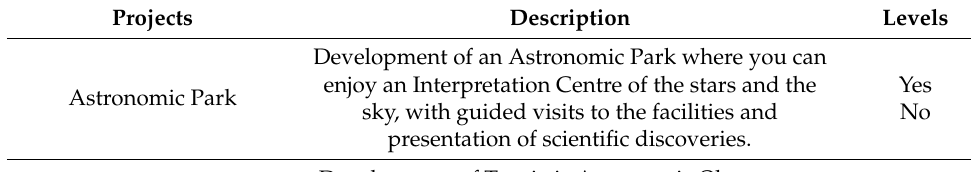
Table 1. Description and levels for DCE of the stargazing land resource projects.